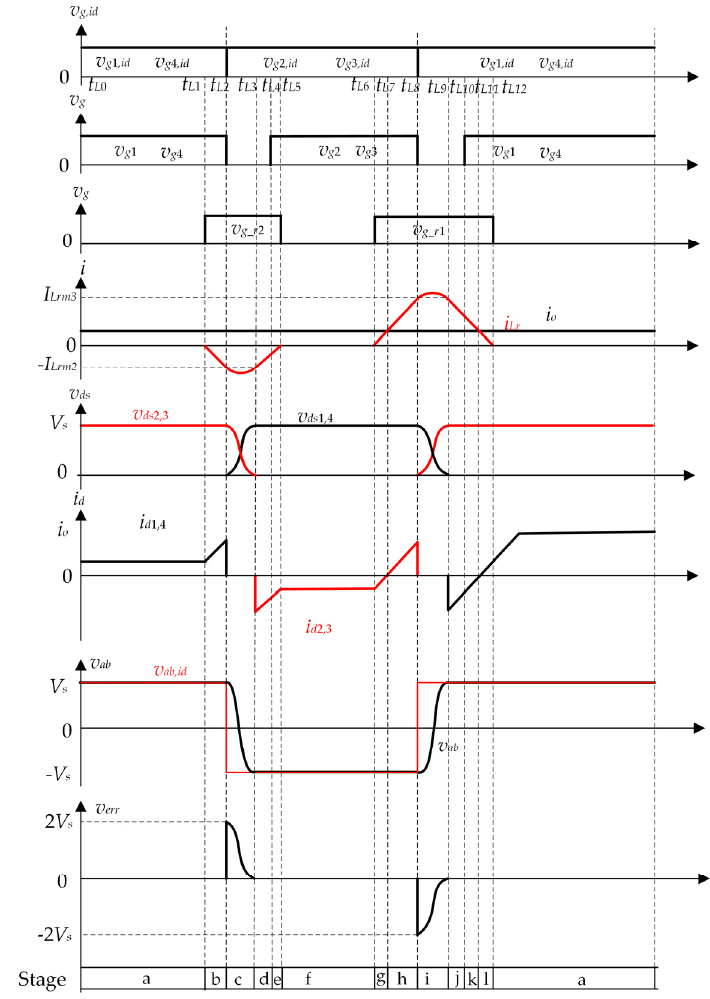
Figure 3. Key waveforms of the ARSI in the light load condition.